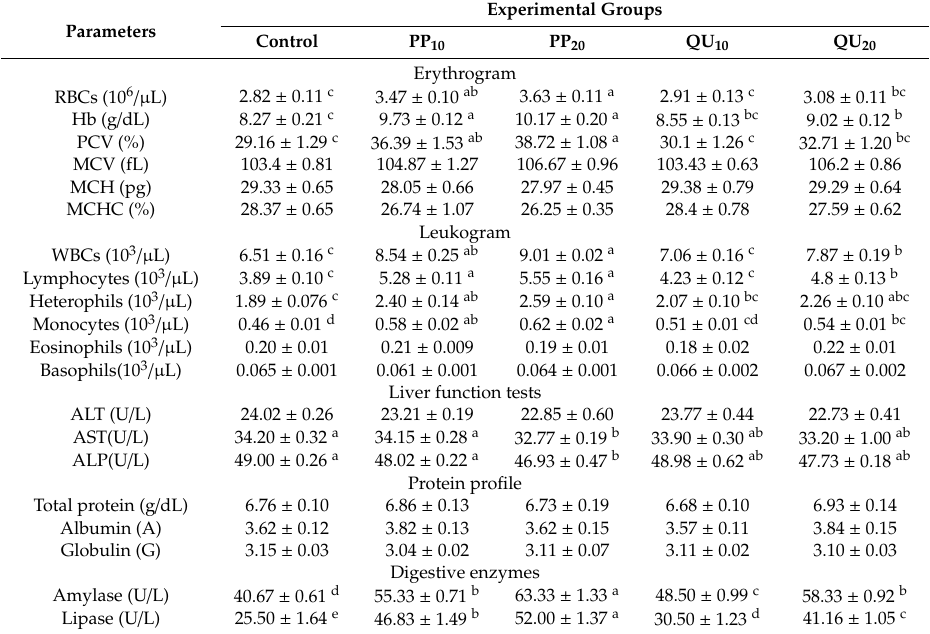
Table 3. E ff ect of PP or QU supplementation for 45 days on the hematologic and serum physiological variables in Nile